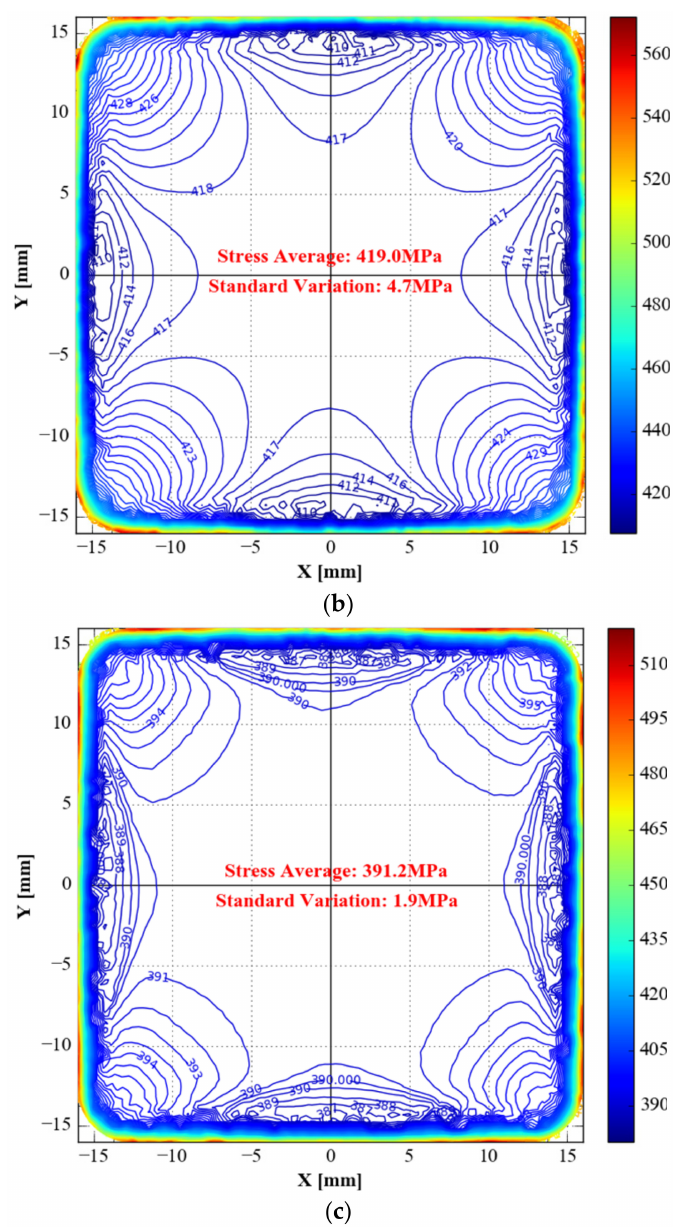
Figure 11. von Mises stress of the three specimens. ( a ) Type A: optimised specimen; ( b ) type B: specimen with topology-only optimization; ( c ) type C: specimen with topology combined with shape